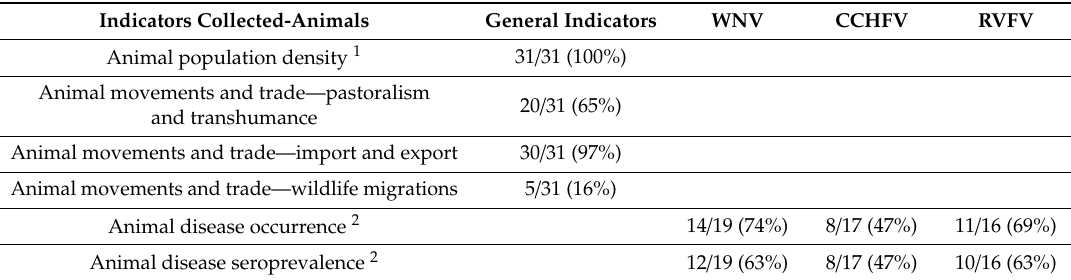
Table 7. Collection of selected indicators for animals for WNV, CCHFV, and